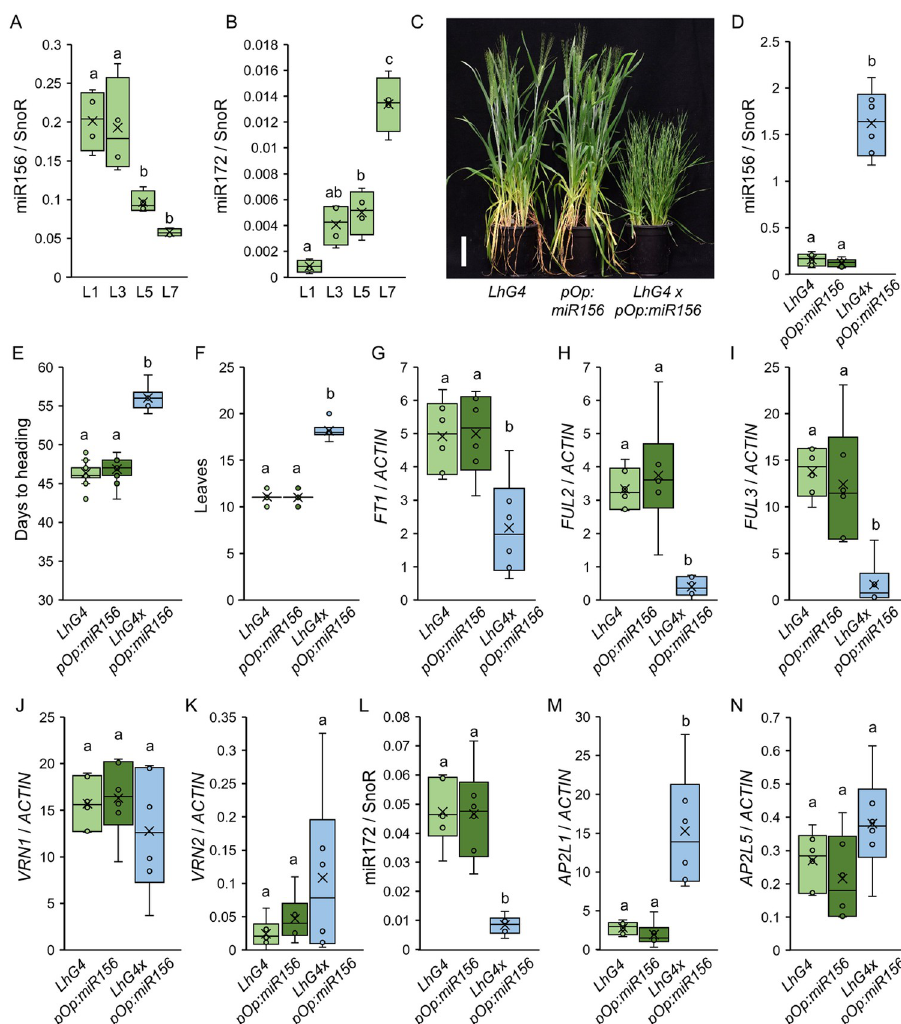
Fig 3. Overexpression of miR156 delays the flowering transition in wheat. ( A-B ) Box plots showing the expression levels of miR156 ( A ) and miR172 ( B ) determined by qRT-PCR in the 1 st (L1), 3 rd (L3), 5 th (L5) and 7 th (L7) leaves of wild type Kronos plants growing under LD. SnoR was used as an internal reference. Data correspond to four independent biological replicates. ( C-N ) UBI : LhG4 ( LhG4 ), pOp : miR156 and UBI : LhG4/pOp : miR156 plants pro pro growing under LD. ( C ) Six-week-old plants. Scale bar = 10 cm. ( D ) Box plots showing miR156 expression levels determined by qRT-PCR in the 9 th leaf. Data correspond to six independent biological replicates. ( E-F ) Box plots showing days to heading ( E ; n � 6) and the number of leaves produced by the main tiller before the transition to the spike ( F ; n � 6). ( G-N ) Box plots showing the expression levels of FT1 ( G ), FUL2 ( H ), FUL3 ( I ), VRN1 ( J ), VRN2 ( K ), miR172 ( L ), AP2L1 ( M ) and AP2L5 ( N ) determined by qRT-PCR in the 9 th leaf. ACTIN was used as internal reference for FT1 , FUL2 , FUL3 , VRN1 , VRN2 , AP2L1 and AP2L5 , and SnoR was used for miR172. Data correspond to six independent biological replicates. Different letters indicate significant differences in Tukey tests ( P < 0.05), except for panel ( F ) where non-parametric Kruskal-Wallis pair-wise tests were used (Data C in S1 Data). (Fig 4B) and characterized their flowering phenotypes under LD conditions. The MIM156 plants headed 4 days earlier (Fig 4C) and produced 1–2 fewer leaves than the non-transgenic sister lines (Fig 4D), indicating an early transition to reproductive development. We then checked the expression of flowering genes in the first, third and seventh leaves of wild type and MIM156#2 plants grown under LD conditions. Consistent with their early flowering, the third